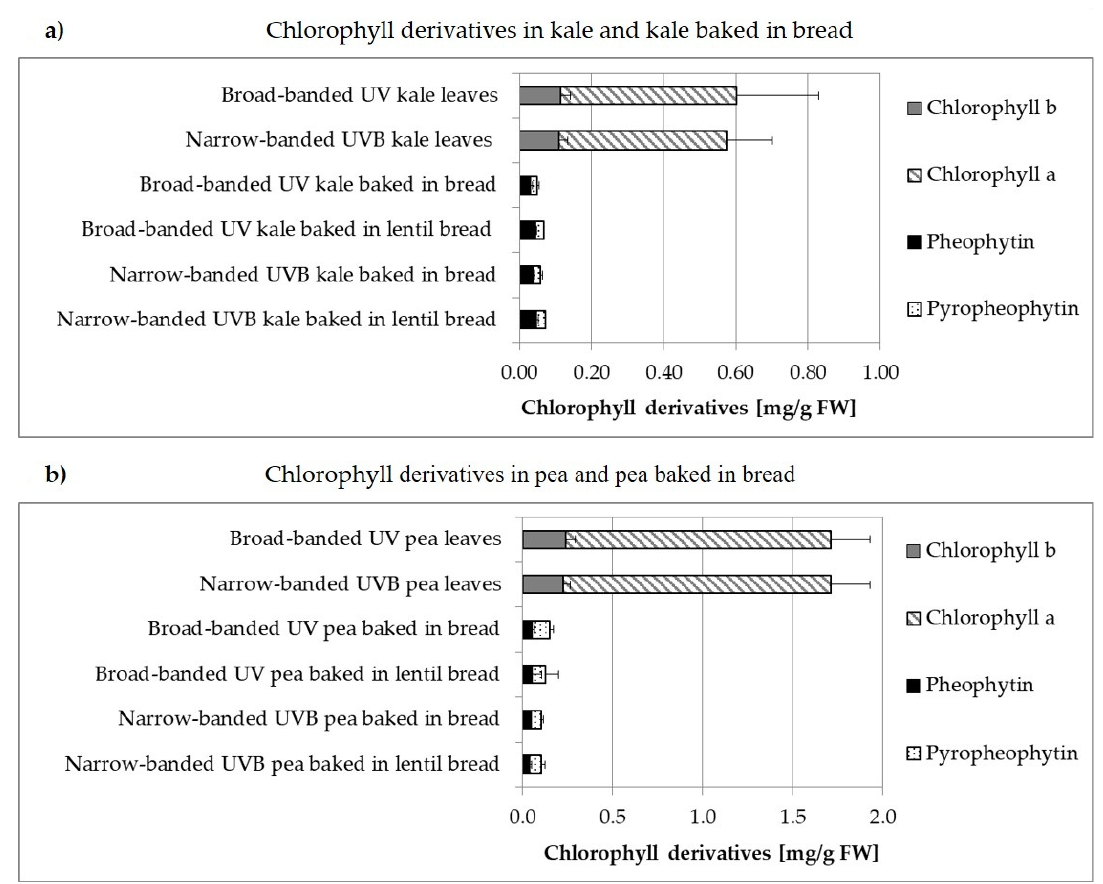
Figure 2. Chlorophyll derivatives in ( a ) kale baked in bread and ( b ) pea baked in bread in mg / g FW. Concentrations of chlorophyll in ‘kale baked in (lentil) bread’ and ‘pea baked in (lentil) bread’ refer to the proportion of plant material, hereby simplifying the comparability of the results of the ‘vegetable breads’ with the results of the corresponding plants.